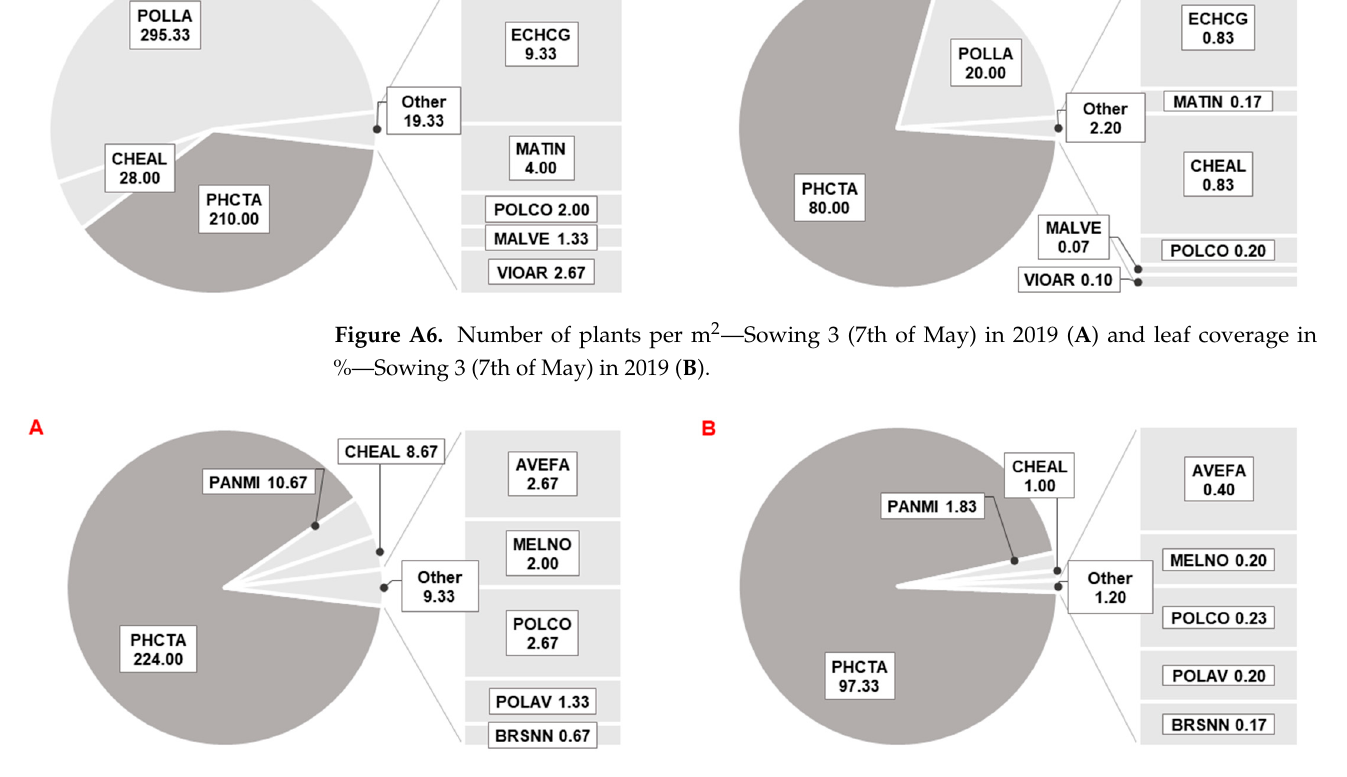
Figure A7. Number of plants per m 2 —Sowing 1 (8th of April) in 2020 ( A ) and leaf coverage in %—Sowing 1 (8th of April) in 2020 ( B ).